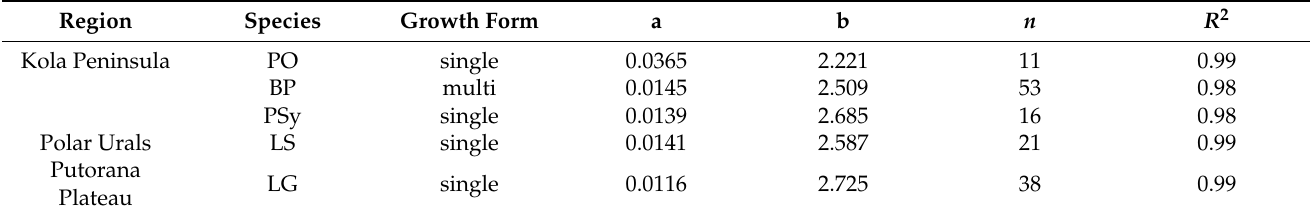
Table 3. Parameters of exponential equations (y = ax b ) modeling the dependency of total above- ground biomass (kg tree − 1 ) on stem basal diameter for Picea obovata (PO), Betula pubescens ssp. tortuosa , (BP), Pinus sylvestris (PSy), Laric sibirica (LS), and Larix gmelinii (LG) growing in the treeline ecotone in the study regions. Parameters were determined for different tree species, for trees with single-stemmed (single), or multi-stemmed (multi) growth forms (Kola Peninsula only). The number of model trees used to establish the relationship ( n ) and the coefficient of determination ( R 2 ) for the relationship in these models are